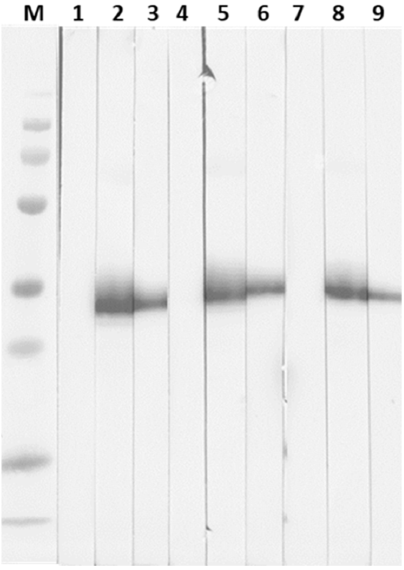
Figure 8. Western blot analysis of 40591-MM43 mAb to spike RBD-His recombinant protein (WT, Delta, and W436R). Proteins (strip 1-3 WT; strip 4-6 Delta; strip 7-9 W436R) on the blot were probed with SARS-CoV-2 spike RBD mAb (40591-MM43) (strips 1, 4, and 7); SARS-CoV-2 spike RBD mouse pAb (4059 2-MP01) (strip 2,5, and 8); mouse anti-6x His mAb (strip no. 3,6, and 9) followed by goat anti-mouse Igs conjugated with